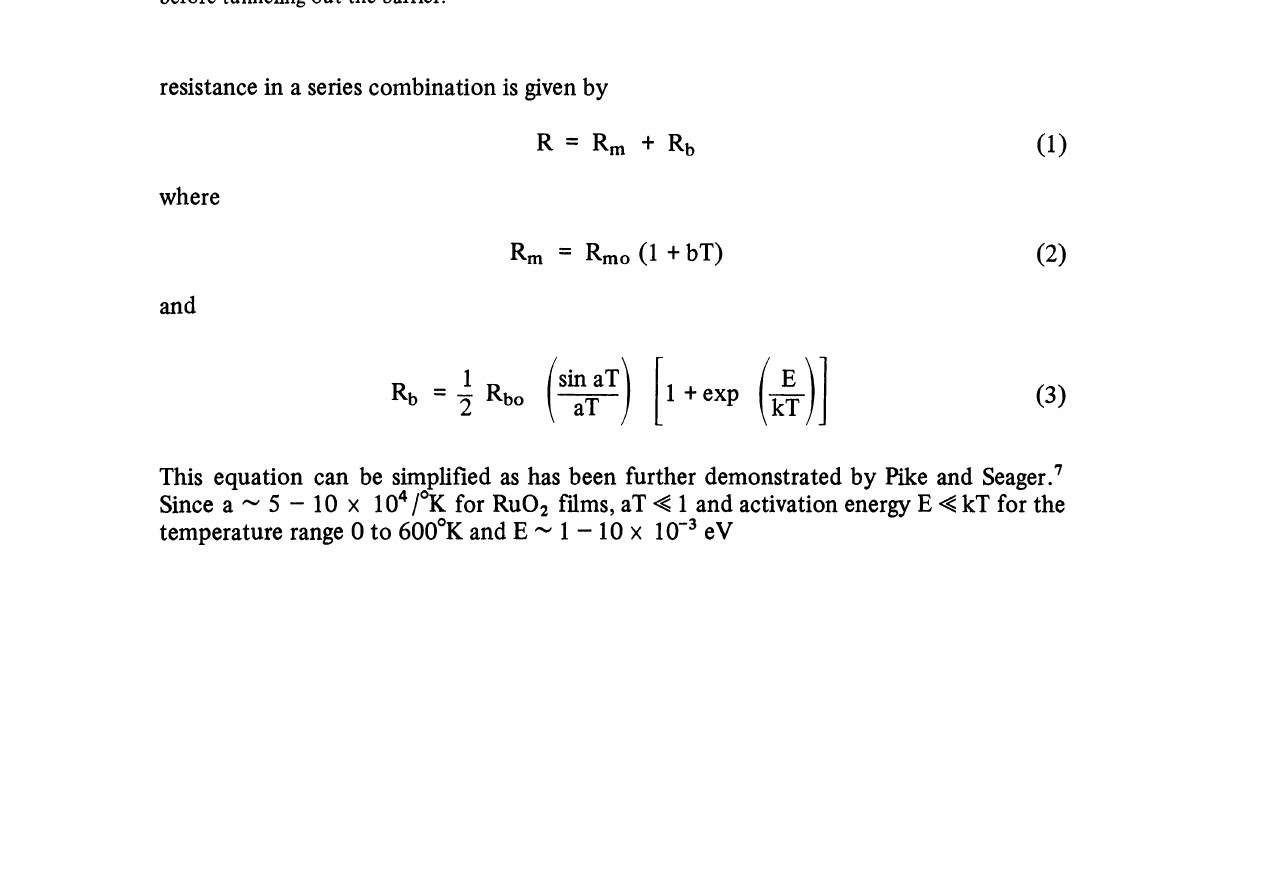
TUNNELING BARRIER